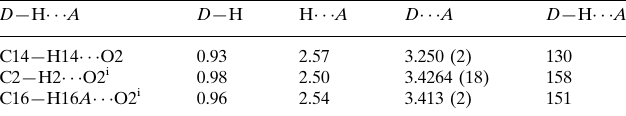
Hydrogen-bond geometry (A˚ , (cid:1)